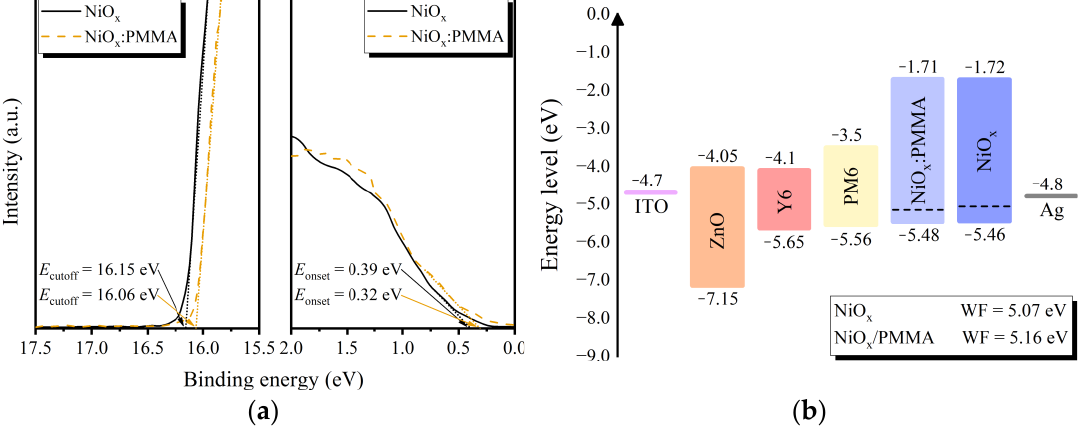
Figure 5. ( a ) UPS spectra of cutoff/onset region for NiO x and NiO x :PMMA. ( b ) Schematic diagram of energy level alignments of OSCs.